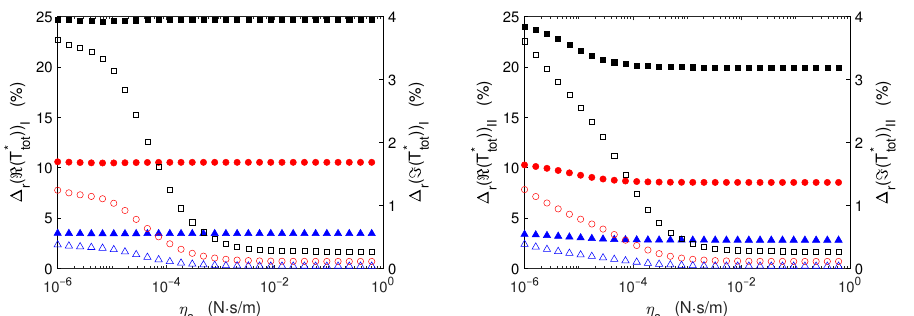
Figure 7. Total drag force relative differences between the solutions with different mesh sizes taking as a reference the 2520 × 1260 mesh solution for the real part, ∆ r ( (cid:60) ( T ∗ tot )) (solid symbols), and the imaginary part, ∆ r ( (cid:61) ( T ∗ tot )) (open symbols). Black symbols: 200 × 100 mesh. Red symbols: 440 × 220 mesh. Blue symbols: 1000 × 500. Left panel: PV-I, right panel: